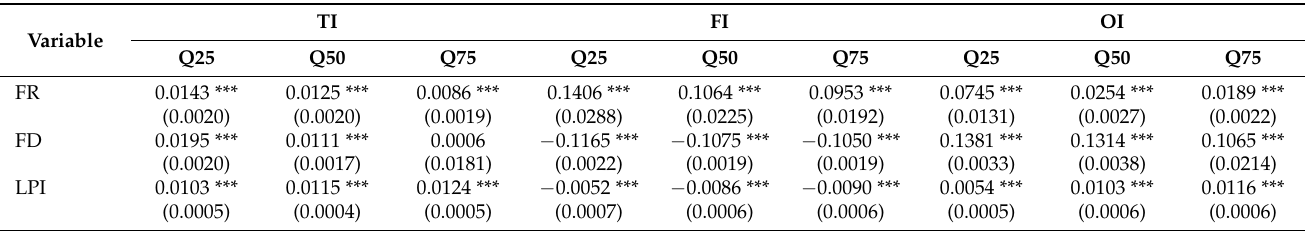
Table A2. Income-increasing effect of collective forestland tenure reform on households with different incomes—quantile